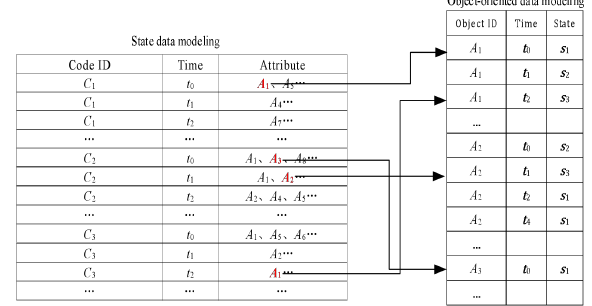
Figure 2. Mixed data model: mixed state modeling and object-oriented